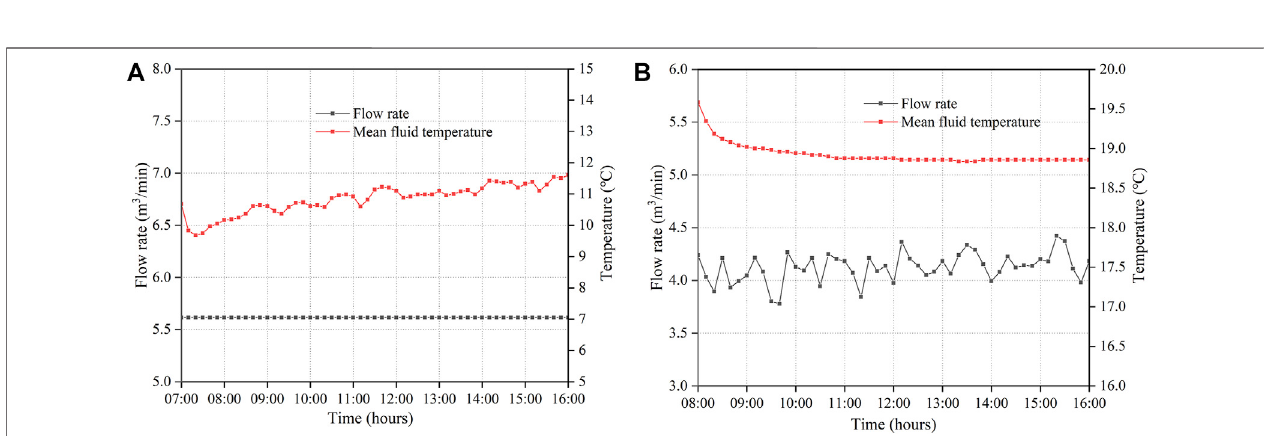
FIGURE 4 | Mean fl uid temperature and fl ow rate as functions of time during (A) heating period (January 26, 2017) and (B) cooling period (July 6, 2017).